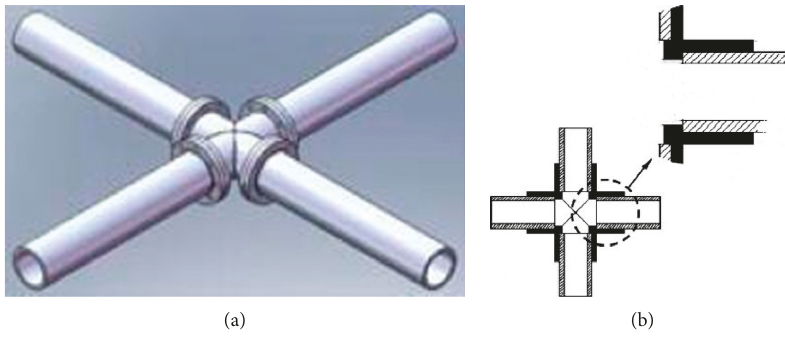
Figure 12: The geometry of joint used by Austin et al.